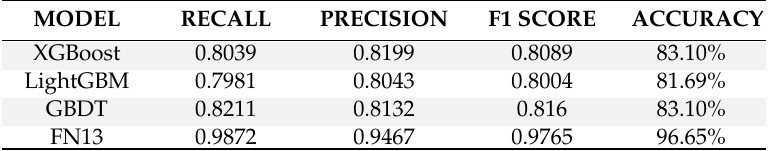
Table 6. The performance of the proposed FN13 compared to various classifiers on LFW dataset.